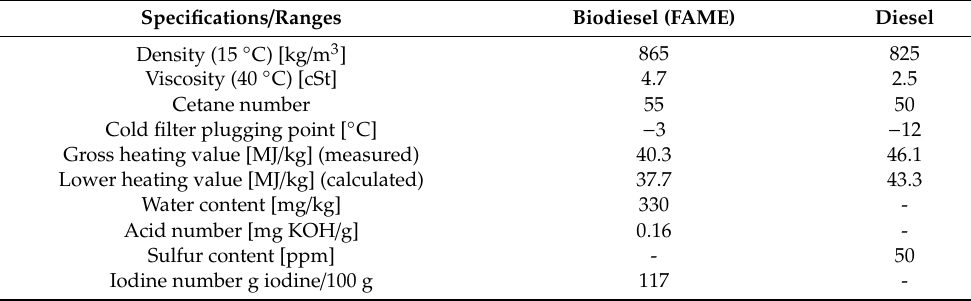
Table 6. Comparison of the main fuel properties, between biodiesel and diesel